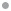
Titration curves of polyvalent antivenoms against the venoms of three lineages of B. asper venoms.Antivenoms INS-COL (●), PROBIOL (●), ICP (○) were serially diluted by a factor of two (starting from a dilution of 1/1000) and tested by ELISA against the following crude venoms: B. asper (sensu stricto) (A), B. rhombeatus (B) and B. ayerbei (C). Equine normal serum was included as negative control (◆). Each point represents the mean ± SD of three independent determinations. Statistically significant differences were observed among the titers of the antivenoms INS-COL vs. PROBIOL and/or ICP against the venoms of B. asper (dilutions 1: 1000, 8000, 16000, 64000), B. rhombeatus (dilutions 1:2000–128000) and B. ayerbei (dilutions 1:1000–16000).